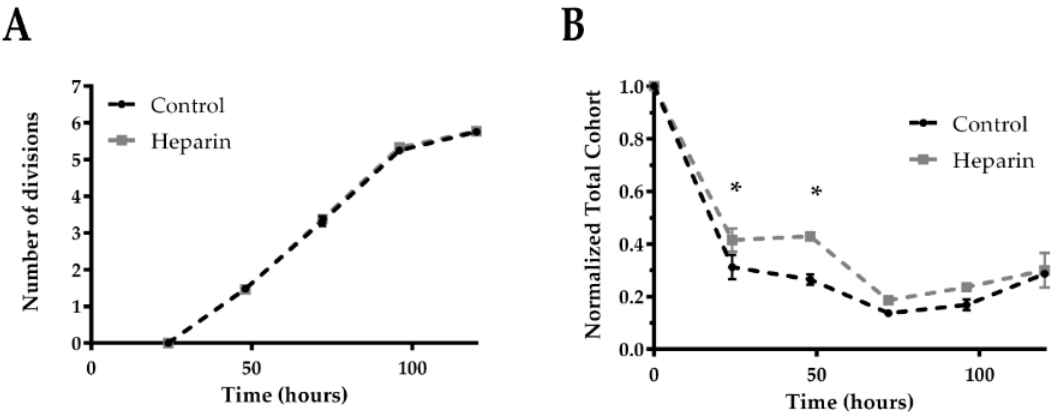
Figure 2. Heparin stimulates murine NK cells survival, but not proliferation in vitro. NK cells were stained with CellTrace violet (CTV) and plated in 96-well plates in the presence of 50 ng/mL rIL-15 and 100 µg/mL heparin and evaluated by flow cytometry every 24 h. The number of divisions ( A ), and total cohort ( B ) were analyzed. Data of three technical replicates of one representative independent experiment out of three. Data are presented as mean ± SEM. Two-way ANOVA was used to compare differences between groups, where * p < 0.05 was considered for statistical significance.